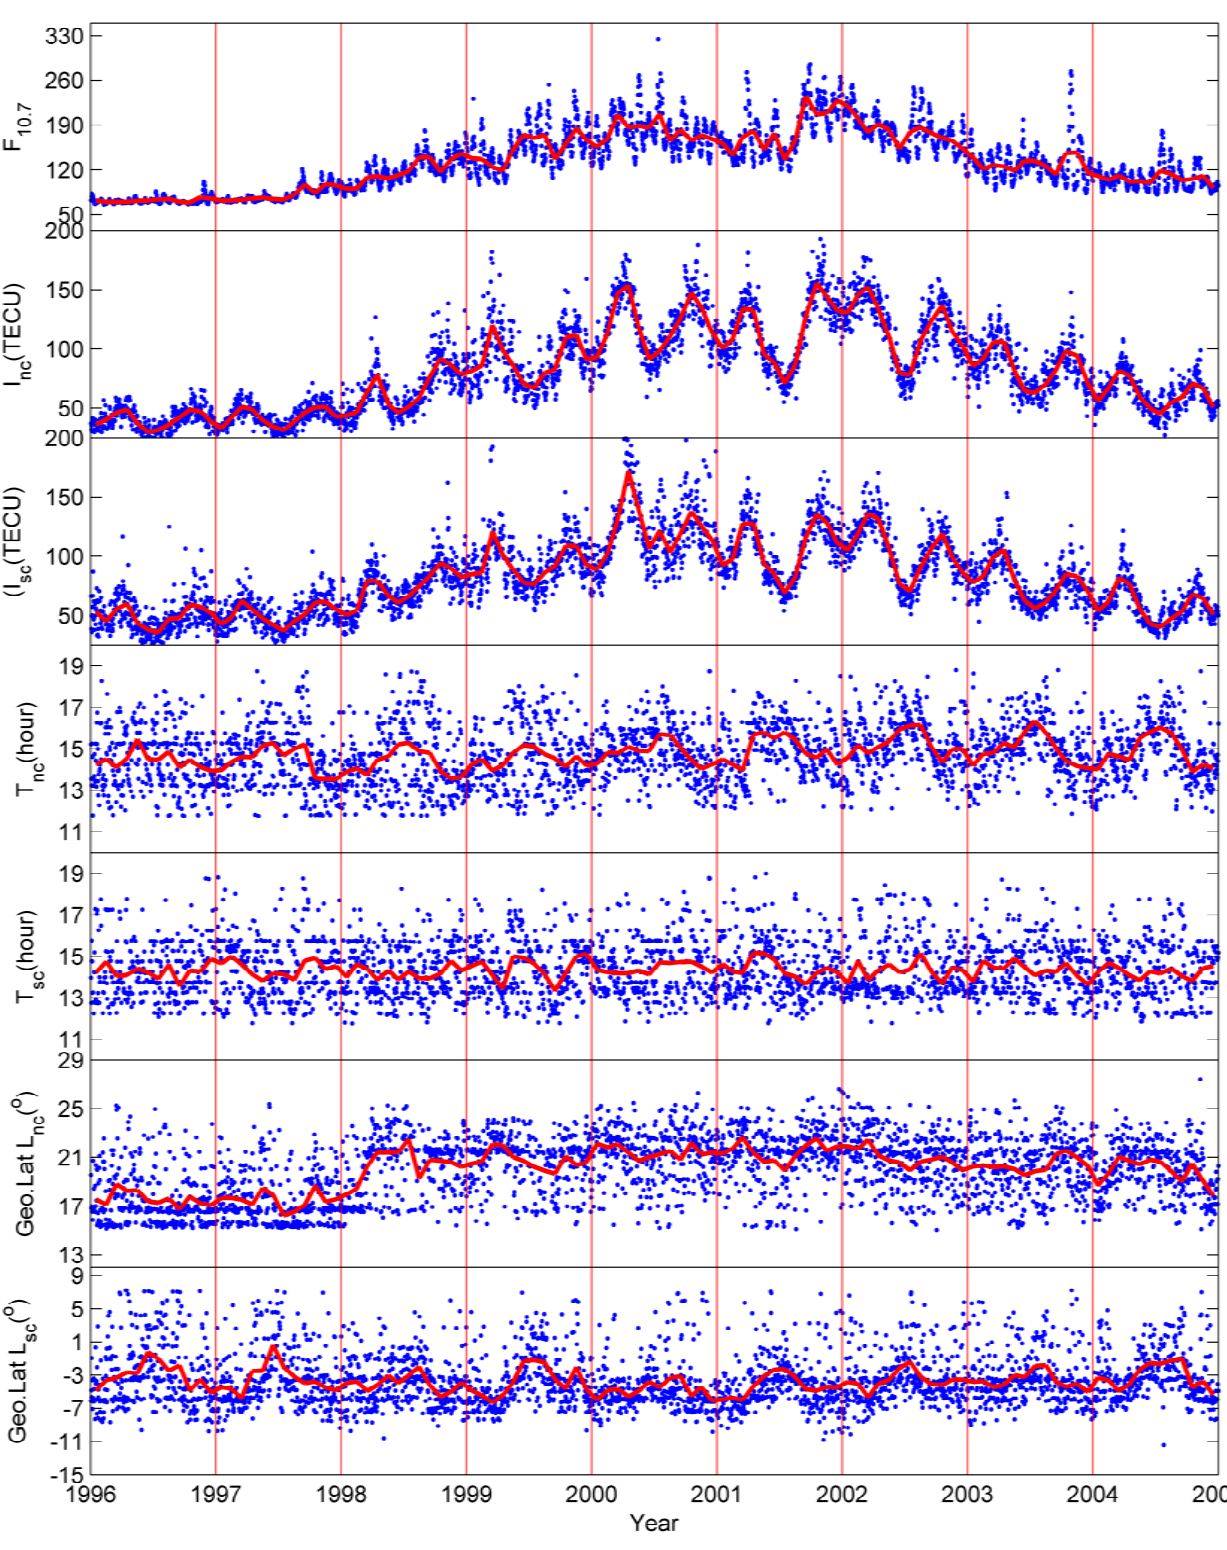
Figure 3. From top to bottom are F 10.7 , the daily strength ( I) , the occurrence local time ( T ) , and the geographic latitude ( L) for the northern ( nc ) and southern ( sc ) EIA crest, respectively. Solid lines show the variation of the corresponding monthly mean values.